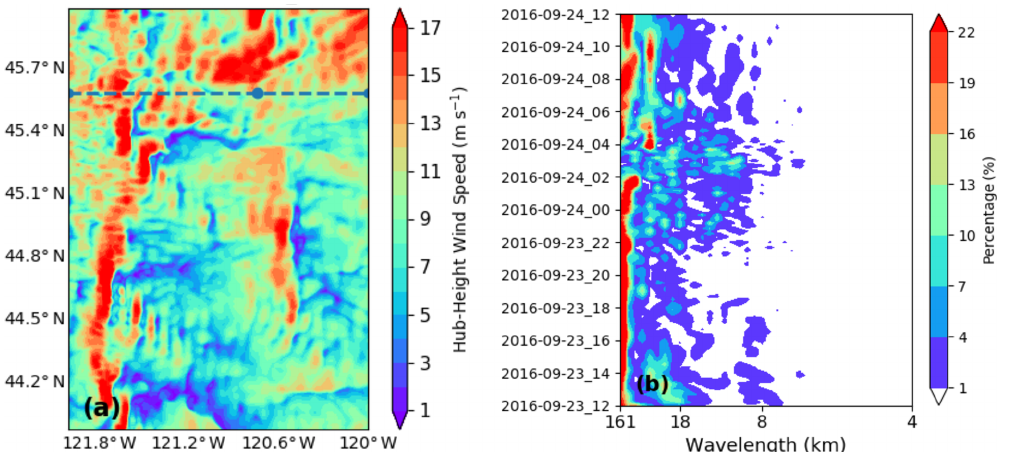
Figure 9. (a) Simulated horizontal wind speeds [ms − 1 ] at 100m on 24 September 2016, at 02:00UTC; the dashed line at 45.6 ◦ N indicates where the FFT was taken. The dotted point represents the location of the sodar site at Van Gilder Road close to Wasco. (b) Hovmöller diagram of power variance with respect to wavelength at the targeted latitude. Please note that the date format in this figure is year month day (yyyy-mm-dd).